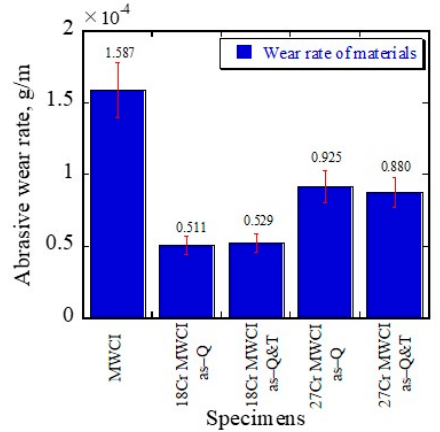
Figure 9. The abrasive performance of each material at the heaviest load.